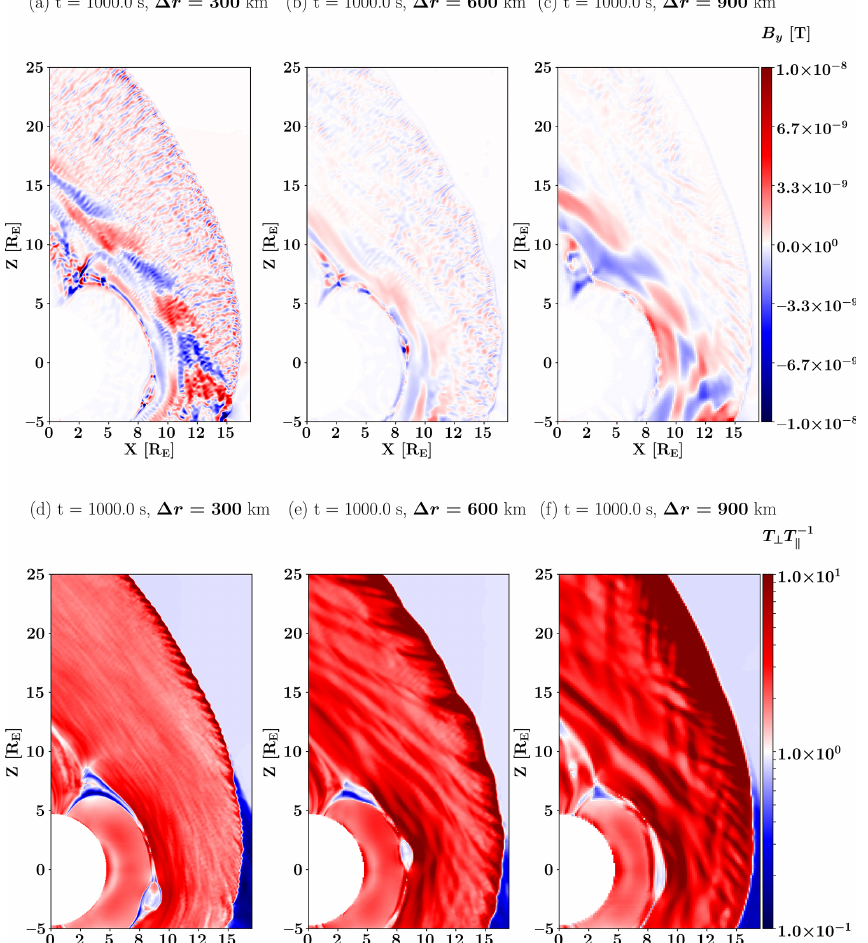
Figure 7. Y component of the magnetic field for the following resolutions: (a) (cid:49)r = 300km, (b) (cid:49)r = 600km and (c) (cid:49)r = 900km. Temperature anisotropy for the following resolutions: (d) (cid:49)r = 300km, (e) (cid:49)r = 600km and (f) (cid:49)r = 900km.